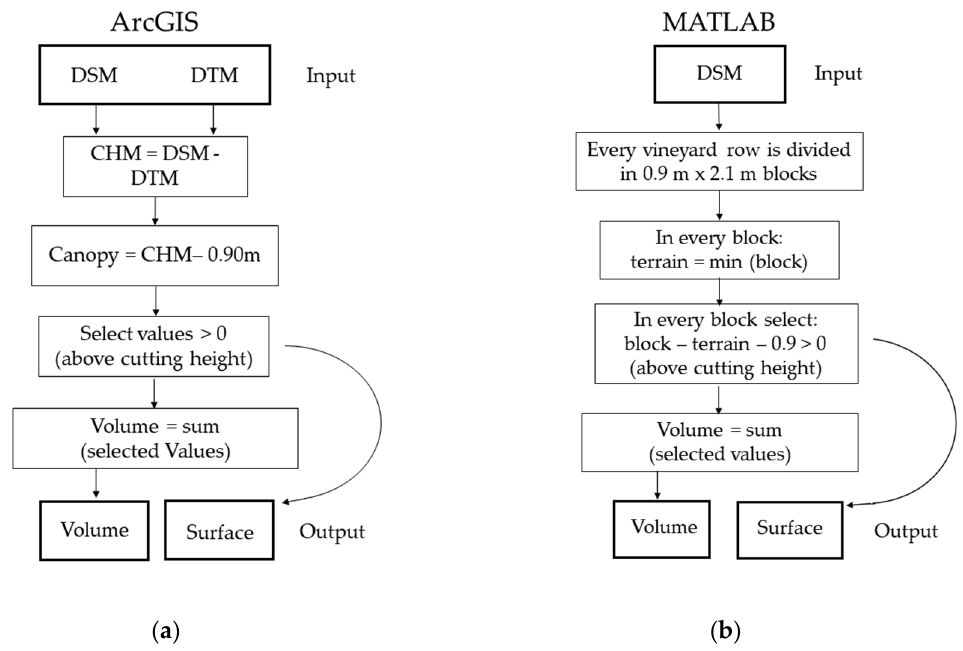
Figure 5. Flowcharts summarizing the two approaches implemented in this study, ( a ) the ArcGIS CHM workflow and ( b ) the MATLAB workflow. CHM workflow and ( b ) the MATLAB workflow.